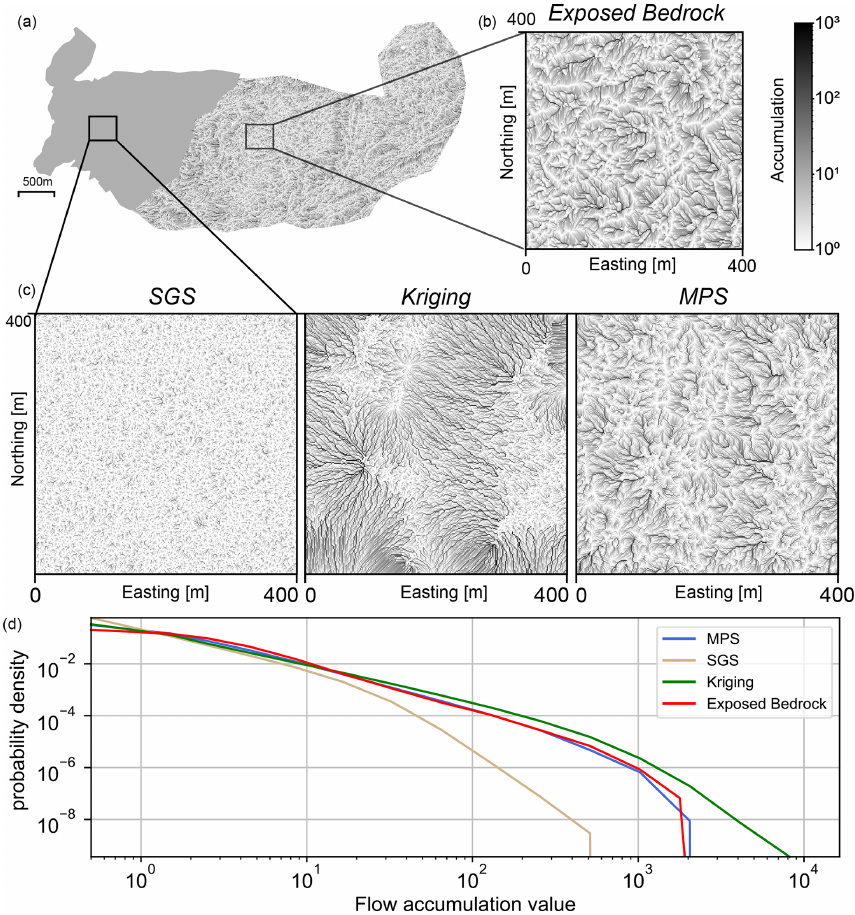
Figure 9. Flow accumulations calculated from the three methods and compared against the one computed in the exposed part of the bedrock used as reference and the probability density of accumulation values. The SGS simulation underestimates the length of the connected path, while kriging overestimates it. The visual patterns and the flow accumulation distribution obtained with MPS are the closest to the exposed bedrock